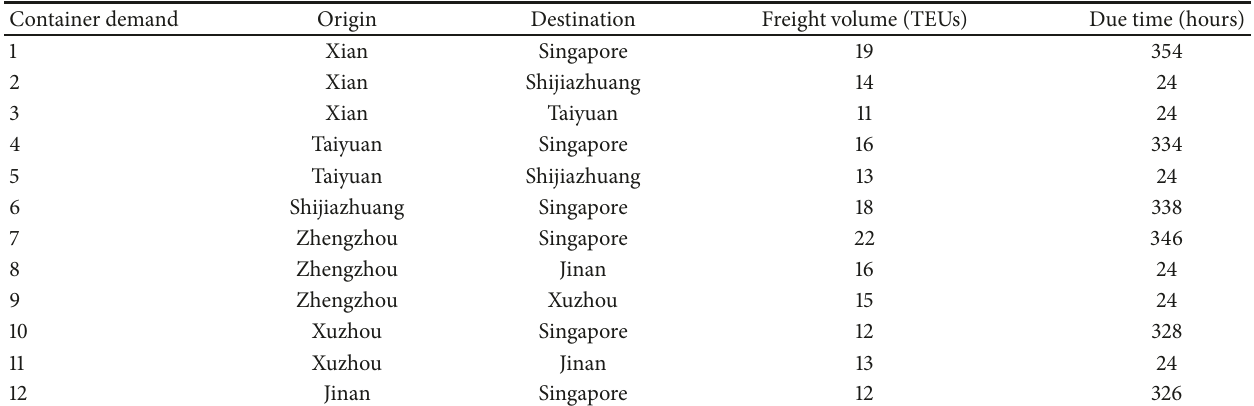
Table 4: The details of container demands.